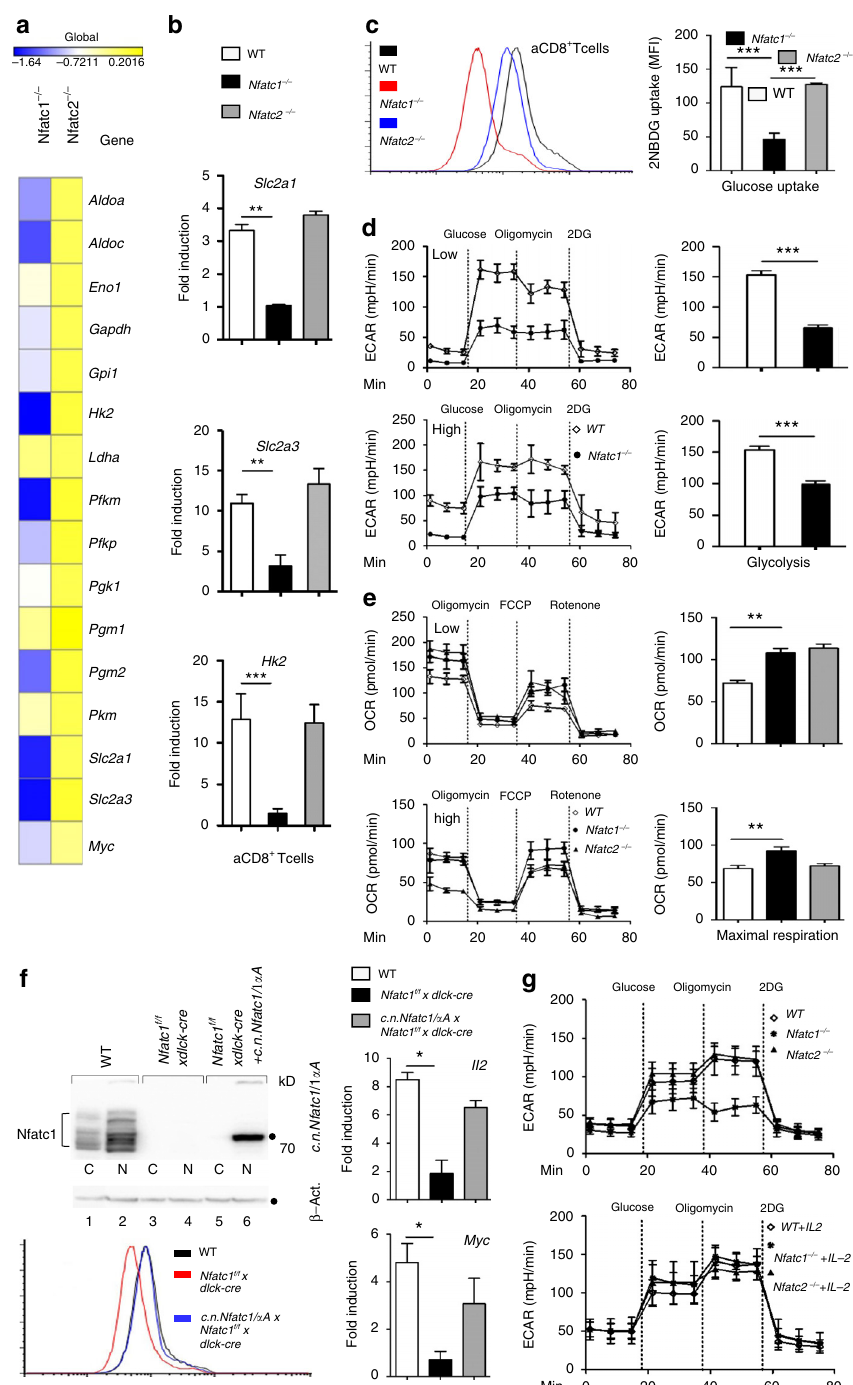
Fig. 7 Reduced metabolic switch in Nfatc1 − / − aCD8 + T cells. a Heat map of RNA expression from genes encoding enzymes of glycolysis in Nfatc1 − / − ( Nfatc1 f/f x CD4-cre mice) and Nfatc2 − / − aCD8 + Ts. b Real-time PCRs of Slc2a1 , Slc2a3 and Hk2 RNAs encoding the glucose transporters Glut1 and Glut3, and hexokinase 2, respectively, normalized by Actb and relative to naïve CD8 + cells. c Incorporation of 2-NBDG into aCD8 + Ts and CTLs upon incubation for 1 h at 37 °C. Data from 4 assays were compiled. d Extracellular fl ux analysis. Above , 4 × 10 5 WT and Nfatc1 − / − CD8 + T cells were stimulated overnight with “ low ” concentrations of plate-bound α CD3 (0.05 μ g/ml) and α CD28 (2 μ g/ml), and subjected to extracellular fl ux analysis. Below , cells activated with “ high ” (standard) α CD3/CD28 concentrations (5/2 μ g/ml) were assayed. e Mito stress test of aCD8 + Ts treated as in d . f Below, incorporation of 2-NBDG ( above ) and extracellular fl ux analysis ( below ) of aCD8 + Ts from c.n.Nfatc1/ α A x Nfatc1 f/f x dlck-cre mice. Above, immune blots showing the lack of NFATc1 expression in cytoplasmic (CP) and nuclear (N) proteins of aCD8 + Ts from Nfatc1 f/f x dlck-cre mice (lanes 3 and 4), and the expression of c.n.NFATc1/ α A (point) in cells from c.n.Nfatc1/ α A x Nfatc1 f/f x dlck-cre mice (lanes 5 and 6). In lanes 1 and 2, proteins from WT cells were fractionated. Right, RT-PCRs showing Il2 and Myc RNA levels in aCD8 + Ts from WT, Nfatc1 f/f x dlck-cre and c.n.Nfatc1/ α A x Nfatc1 f/f x dlck-cre mice. Data of 5 PCR assays are shown, relative to naïve WT CD8 + T cells and normalized to Actb . Data are shown as means ± SEM. Unpaired Student ’ s t -test was used for statistics. g Extracellular fl ux analysis of CD8 + T cells from WT and Nfatc1 f/f x CD4-cre mice stimulated by α CD3/CD28 (5/2 μ g/ml) without ( above ) or with 100 U/ml hIL-2 ( below ) for 3 d. All assays were performed three times or